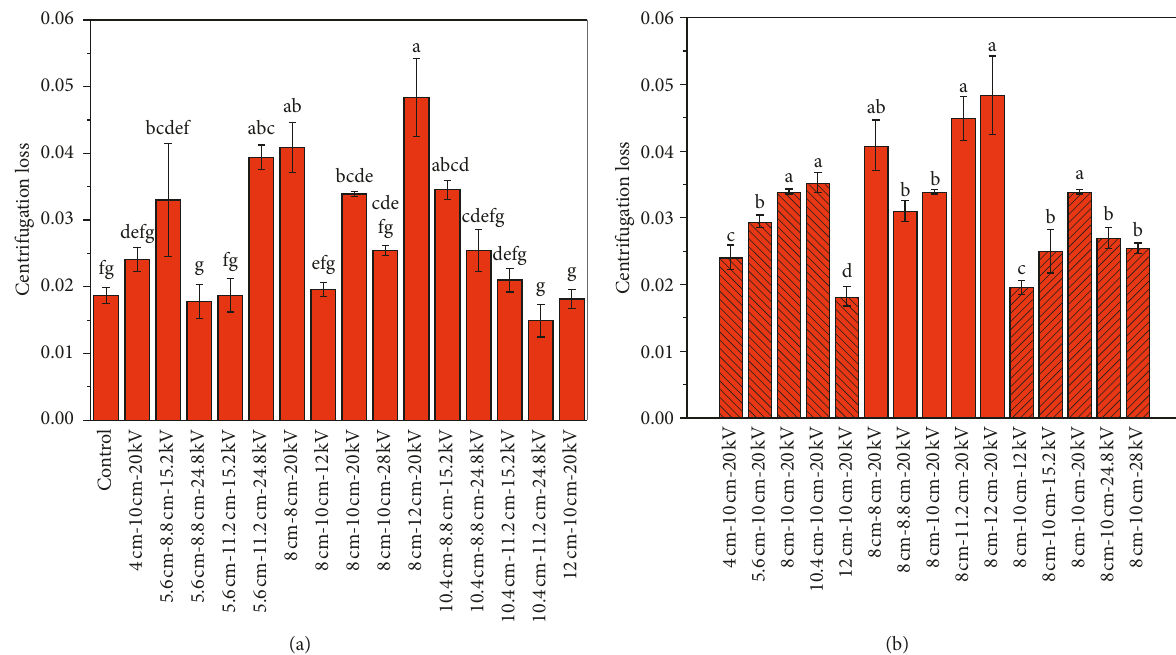
Figure 5: Effect of different treatments on centrifugation loss. (a) The response surface methodology; (b) the single electric parameter analysis. Data are shown as the mean ± SD for each response. For each response, means with different lowercase letters are significantly different ( p < 0 . 05). The order of the parameters is needle distance, electrode, and voltage.